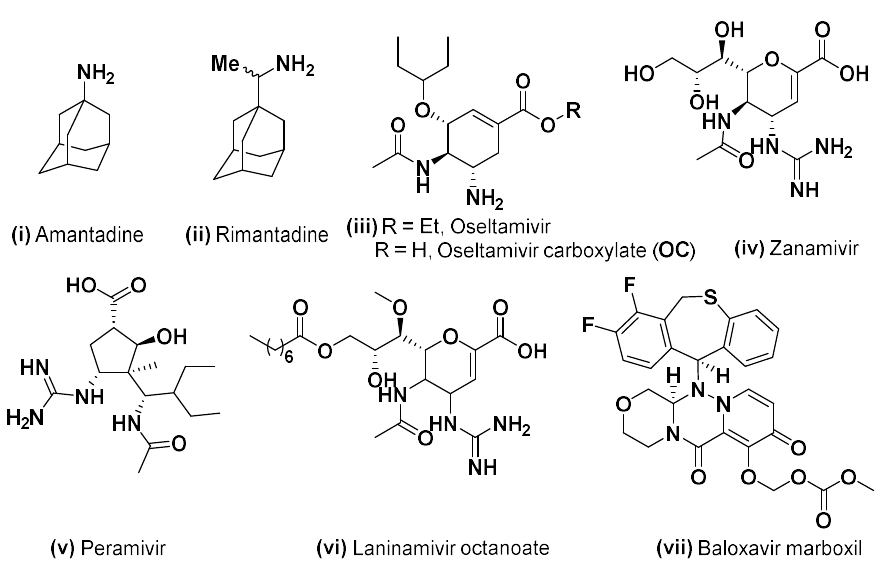
Figure 1. Representative anti-influenza drugs. M2 channel inhibitors: ( i , ii ); NAIs: ( iii – vi ) and cap-dependent endonuclease inhibitor ( vii ).